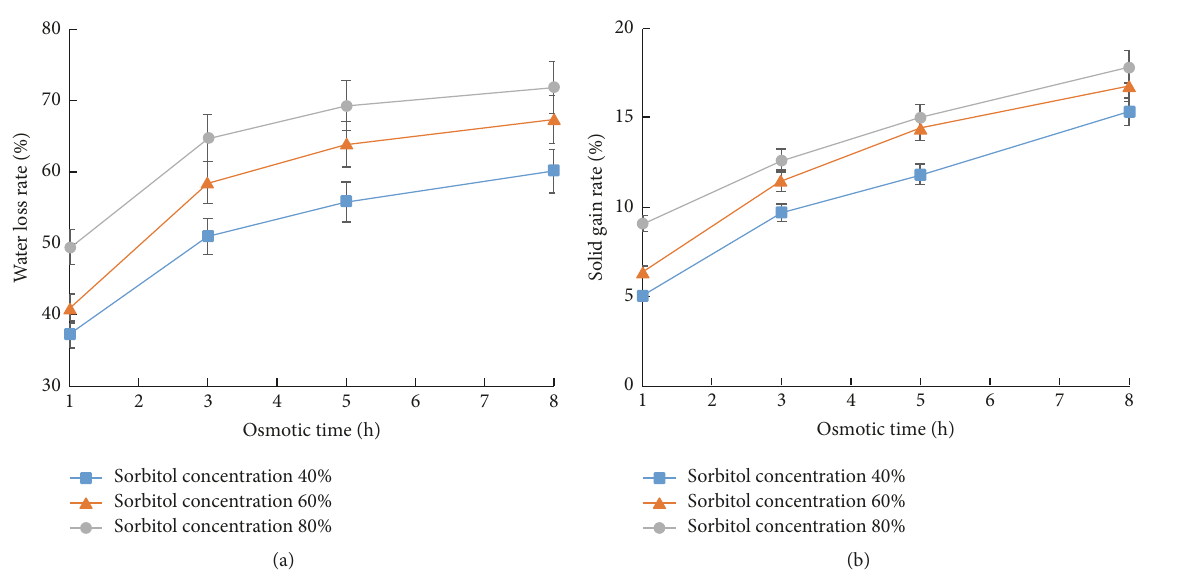
Figure 2: Changes in WL and SG rates for strawberry osmotic dehydration at 60 ∘ C in different sorbitol